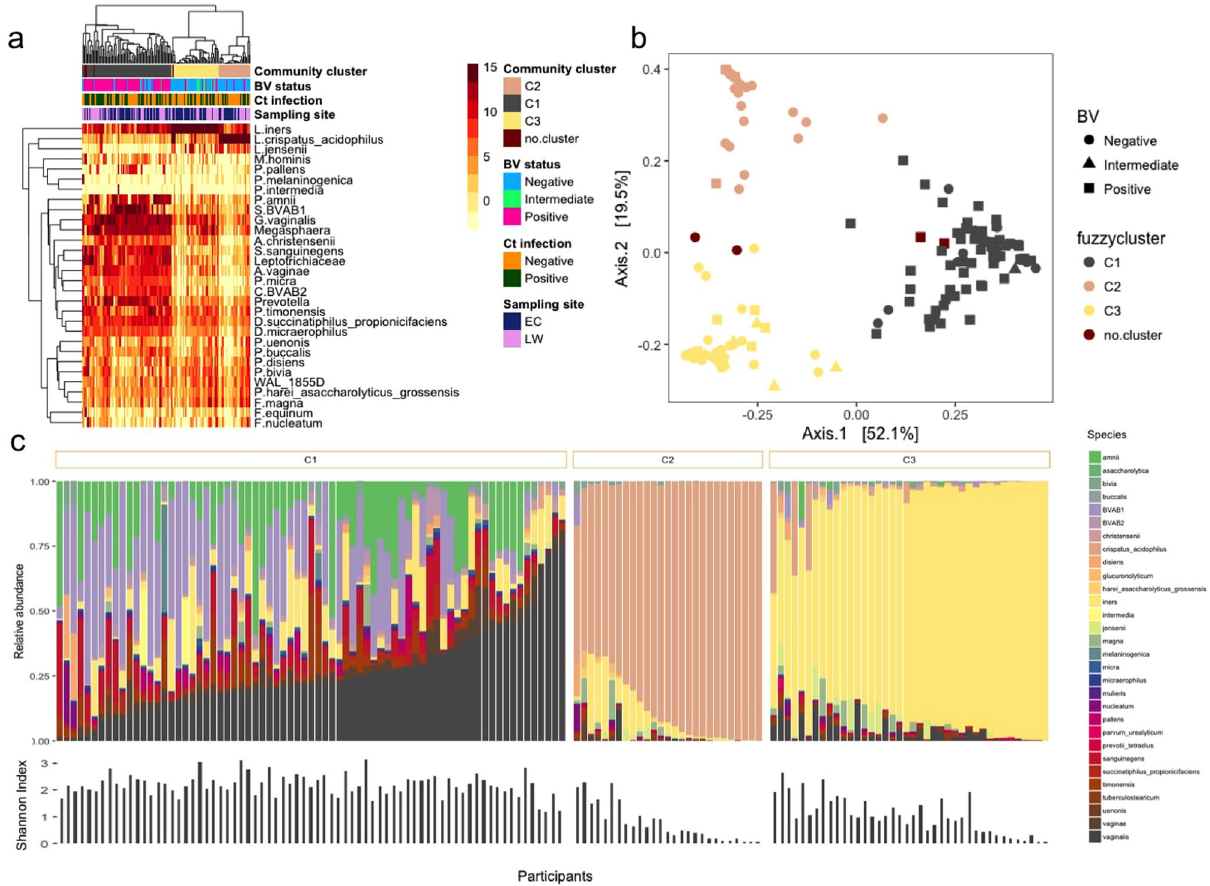
Figure 1. Composition of vaginal lateral wall and endocervical microbiota. ( a ) Heat map of the 30 most abundant taxa (rows) identified by 16S rRNA microbiome profiling using unsupervised hierarchical clustering with weighted UniFrac distances in all samples (columns). Unsupervised hierarchical clustering of 144 matched endocervial and vaginal lateral wall samples from 72 participants. The dendrogram was generated using average linkage clustering with weighted UniFrac distance, based on the relative abundance of taxa (merged at lowest taxonomic level) in each sample. Log2-transformed standardized read counts are illustrated by the colour key. Annotation bars above the heatmap depict community type cluster (top bar), BV status based on Nugent scoring (upper middle bar), C . trachomatis (Ct) infection status (lower middle bar) and anatomical sampling site (bottom bar). Samples that did not meet the minimum probability of ≥ 60% of belonging to any of the three clusters were excluded from downstream analyses (n = 4, “no.cluster” in figure). ( b ) Barplot of the 30 top most abundant taxa identified by 16S rRNA microbiome profiling. Samples are grouped by microbial compositional subtype (C1, C2, C3) established using Fuzzy clustering with weighted UniFrac distances and ordered based on the abundance of the most dominant species in each community type ( G . vaginalis , L . crispatus and L . iners , respectively). Samples that did not meet the minimum probability of ≥ 60% of belonging to any of tree clusters (n = 4) were excluded from the figure. Shannon diversity Index for each sample is depicted below the barplot. ( c ) Principal Coordinates Analysis (PCoA) of samples colored by compositional subtypes generated using Fuzzy clustering with weighted UniFrac distances. Samples are colored by compositional subtype (C1, C2, C3), with BV status displayed as shapes. Samples that did not meet the minimum probability of ≥ 60% of belonging to any of these clusters were excluded from downstream analyses (n = 4, “no.cluster” in